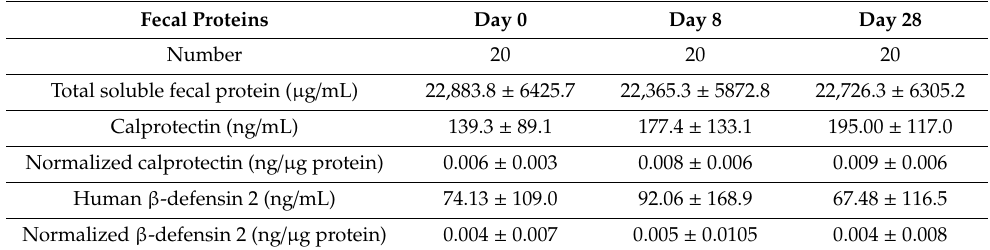
Table 5. Fecal Peptides and soluble protein.